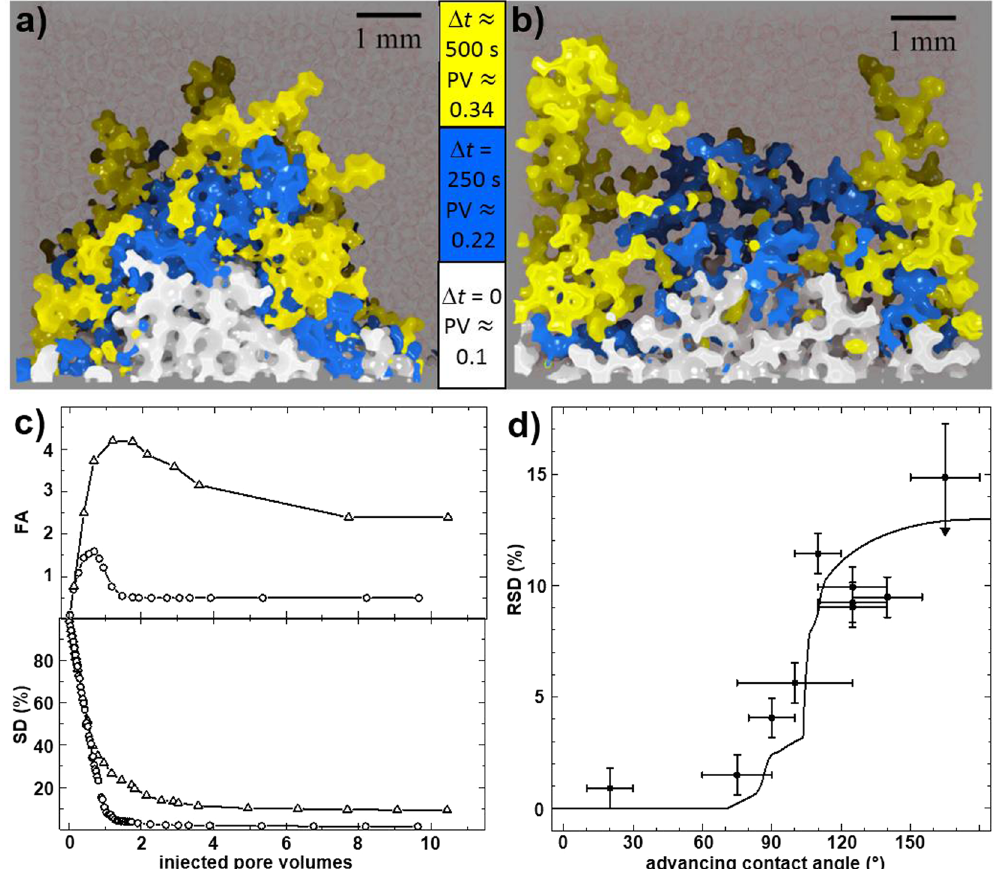
Figure 1. Evolution of an invading liquid front for different contact angles in random bead packs. ( a , b ) Water morphologies invading an oil filled random pile of spherical beads, as revealed by X-ray micro-tomography. Only a slice with a depth of four bead diameters is shown and beads are rendered semi–transparent (reddish hue) for clarity. Different colors of the front correspond to different times t and injected pore volumes (PV). ( a ) basalt beads, θ = (75 ± 15)°, ( b ) glass beads θ = (125 ± 15)°. ( c ) top : Interfacial area of the invading fluid and bottom : Saturation with defending phase as a function of the injected pore volume of the invading phase (given in units of the total observed pore volume in the imaged field of view) for basalt beads (open circles), glass beads (open triangles). The interfacial area was determined as the sum of the fluid–fluid and the fluid–solid interface excluding the completely immersed beads and ganglia of the defending phase and normalized with the sample cross section. The finite plateau values for large injected volumes reflect liquid structures extending across the field of view. ( d ) Residual saturations as a function of contact angle θ . The arrow at the rightmost datum point indicates that at these large contact angles, relaxation times exceeded the duration of the experiment and we could not reach the point where the defending fluid depercolates. Accordingly a lower value of the residual saturation is